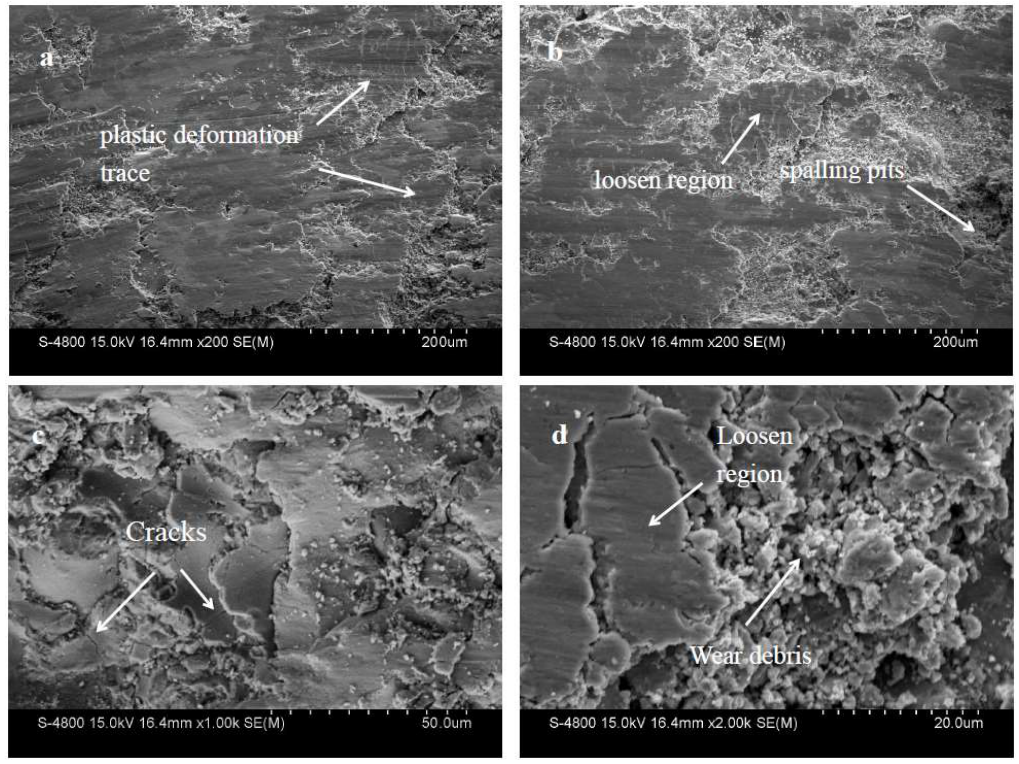
Figure 10. Wear morphology of NTC coating.